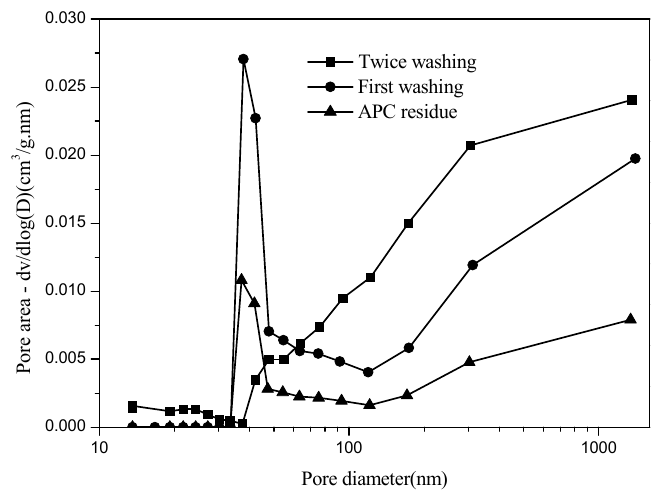
Figure 6. The pore distribution after the first and second washing.